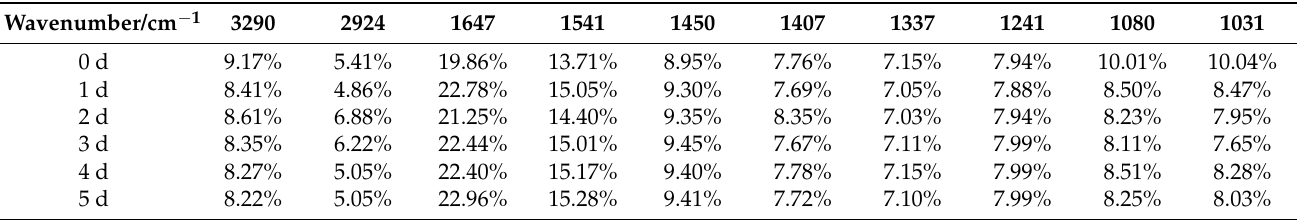
Table 1. The relative absorbance of FTIR spectra of gelatin/zein/glucose nanofibers after Maillard reactions conducted at 60 ◦ C and 50% RH for 0~5 days.